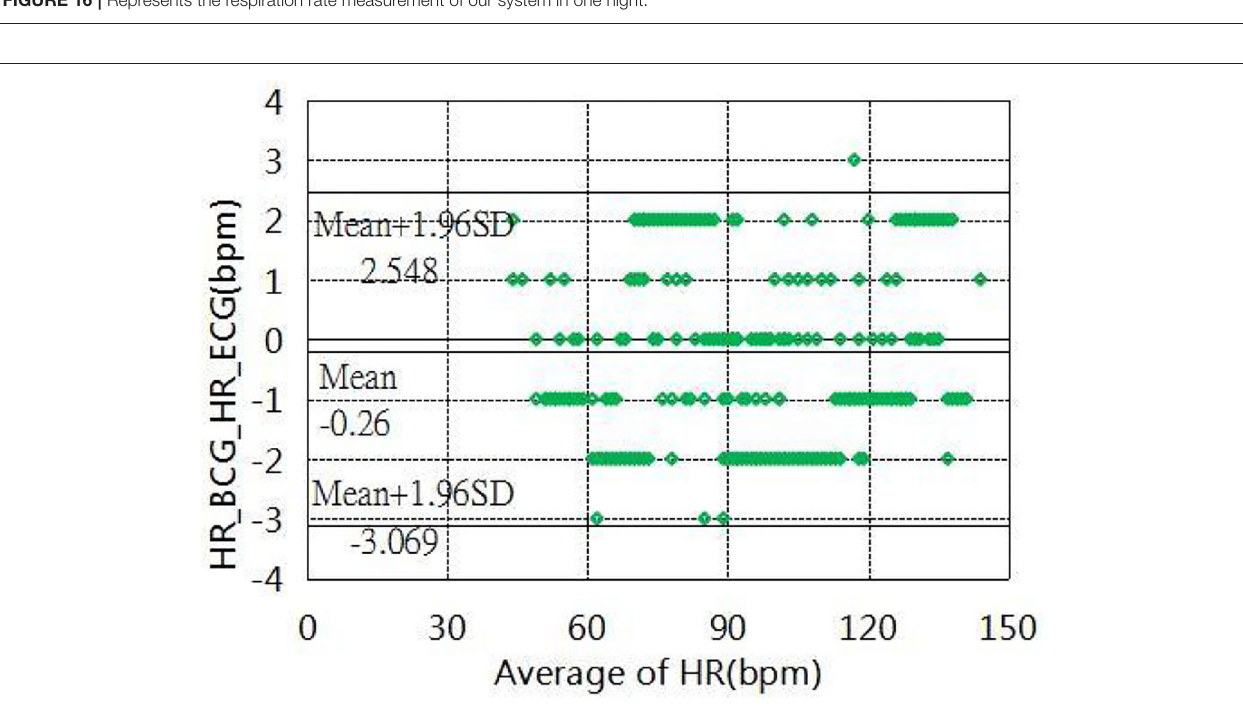
FIGURE 17 | Bland–Altman plot of heart rate estimation.